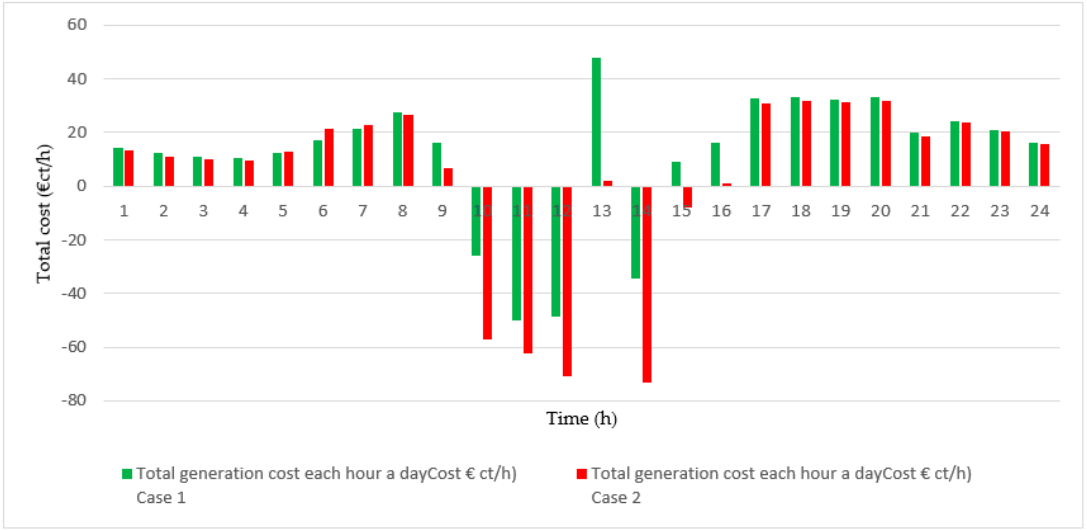
Figure 16. A comparison between the total operation cost for both scenarios.